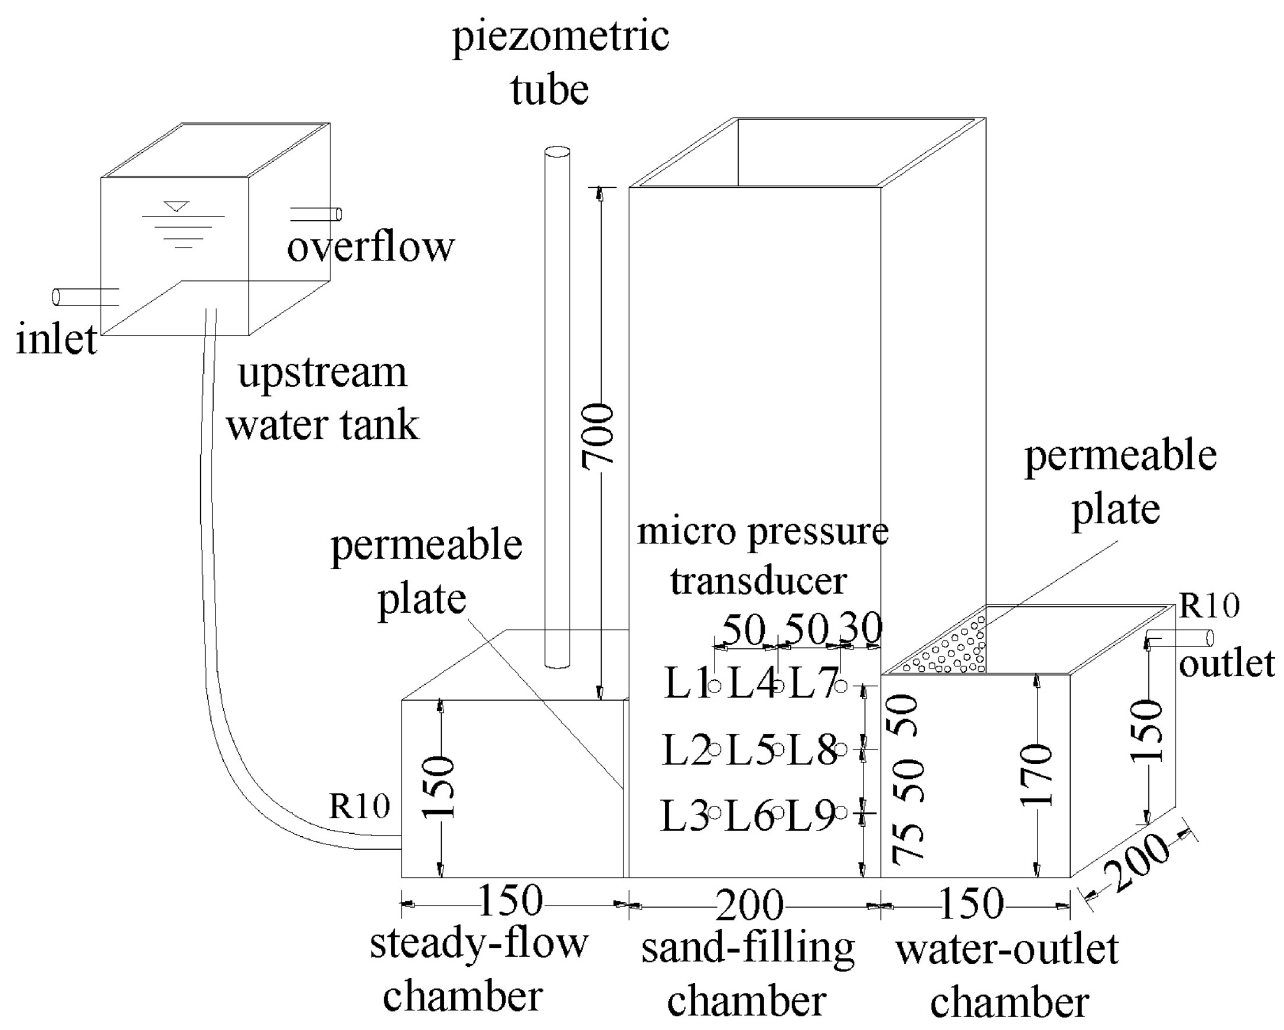
Fig 2. Schematic of apparatus for horizontal seepage failure test (units: mm).